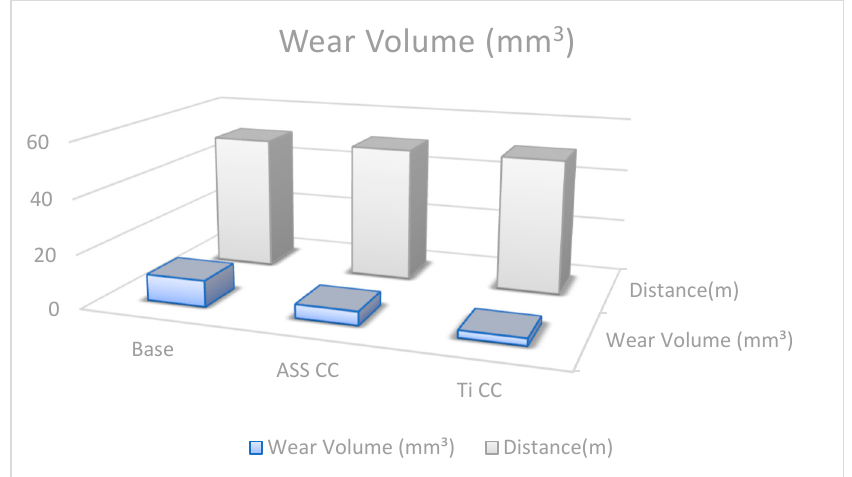
Figure 6. Wear rate diagram of plasma treated and untreated coupons.